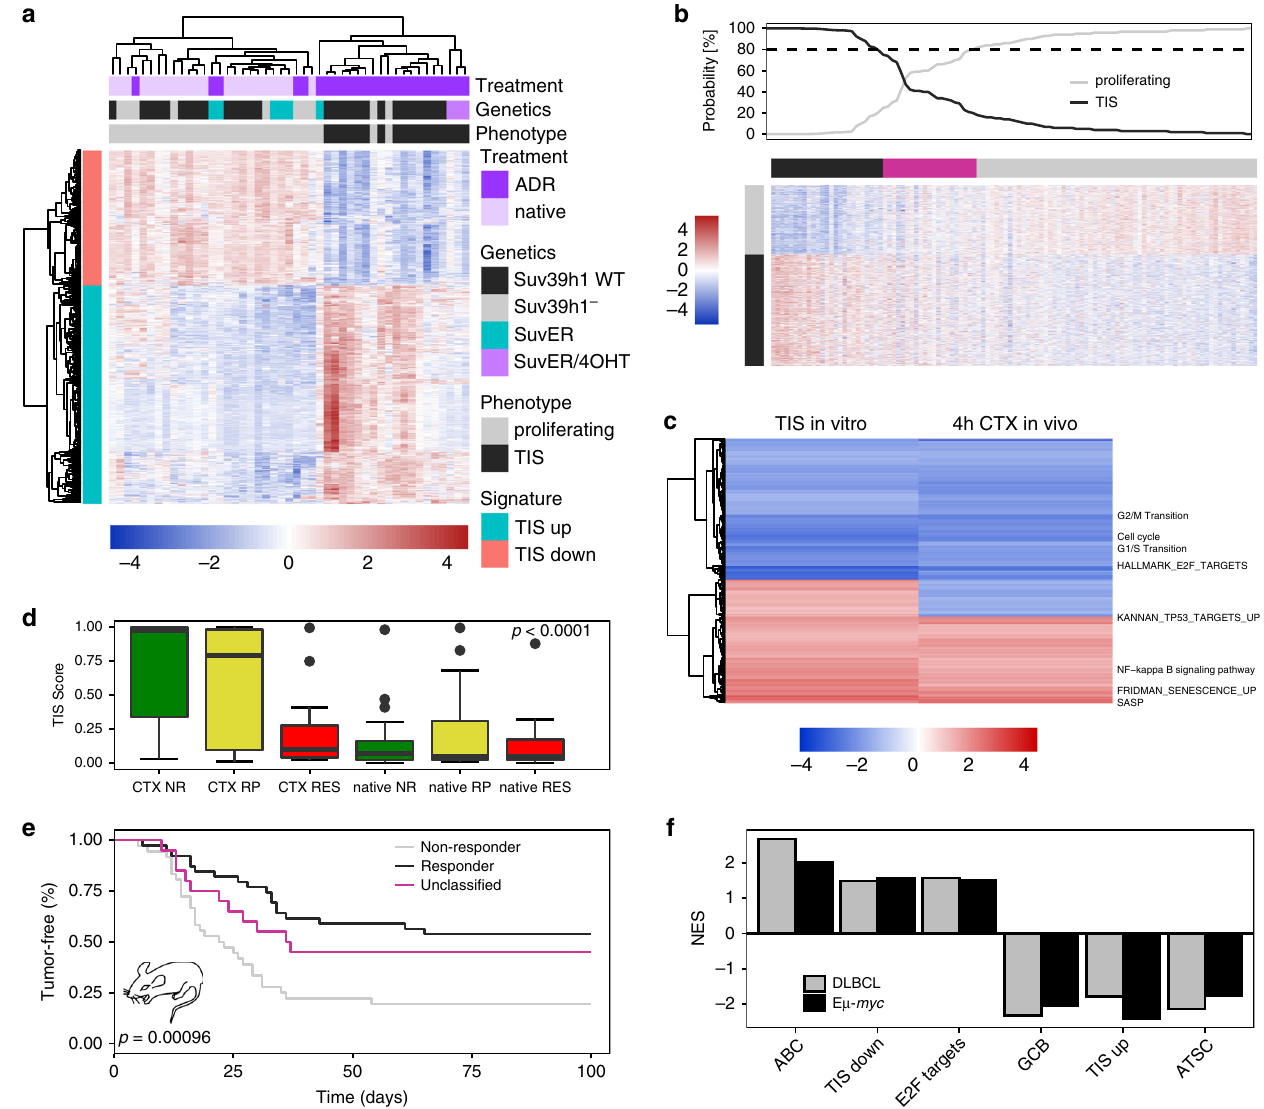
Fig. 5 Senescence defects account for treatment failure. a Heatmap of differentially expressed genes ( p value < 0.01, log-FC > 1) comparing in vitro-ADR- treated control;bcl2 or ADR/4OHT-double-treated Suv39h1:ER;bcl2 senescent (TIS) to ADR-treated Suv39h1 − or Suv39h1:ER;bcl2 senescence-incapable, or untreated non-senescent lymphomas (collectively 47 lymphomas). b Heatmap and associated probability of TIS (black line) vs. no senescence (i.e., proliferating, grey line) in CTX-treated lymphomas based on LPS classi fi cation using data in ( a ), which had 85.1% overall accuracy in a tenfold cross validation of the in vitro-training data. c Heatmap of GSEA Normalized Enrichment Scores (NES) compiled of overall 47 5d ADR-in vitro-treated senescent control;bcl2 lymphomas vs. non-senescent untreated and Suv39h1 − ;bcl2 or non-4OHT-exposed Suv39h1:ER;bcl2 senescence-incapable lymphomas compared to 54 4 h-in vivo-CTX-treated vs. 55 untreated lymphomas. Clustering was performed using Euclidean distance. Senescence-related gene sets are shown, some of them speci fi cally indicated 70 . d Probability of a TIS phenotype according to the LPS classi fi cation (cf. panel b , black line) of 4 h-CTX- treated or untreated lymphomas belonging to the indicated response groups ( n = 20 CTX NR, n = 19 CTX RP, n = 15 CTX RES, n = 20 native NR, n = 19 native RP, n = 16 native RES). Higher TIS scores represent a stronger senescence likelihood, while lower scores indicate a proliferating phenotype. Box-and- whisker plot showing the median (black line inside the box), upper and lower quartile (box edges), minima and maxima (whiskers), and outliers (dots). The p value was calculated using the Kruskal – Wallis rank-sum test. e Tumor-free survival (TTR) of mice bearing senescence responder (TIS score > 0.8; n = 42), non-responder (TIS score < 0.2; n = 38) or unclassi fi ed (0.8 ≤ TIS score ≥ 0.2; n = 22) E µ - myc lymphomas as determined from the LPS classi fi cation (based on the TIS status in the 4 h-CTX-exposed condition [cf. panel d ]). Two mice per lymphoma were used. f GSEA NES results comparing ABC-like to GCB-like subtypes in DLBCL patients (ABC/GCB training set from GSE10846, n = 150) and E µ - myc lymphomas (dataset as used in Fig. 1, ABC/GCB classi fi ed, n =